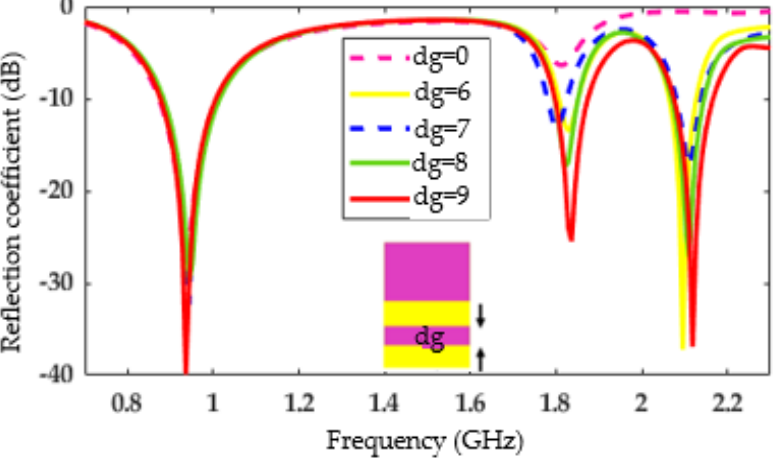
Figure 5. Influence of the parameter, dg, on the reflection coefficient.